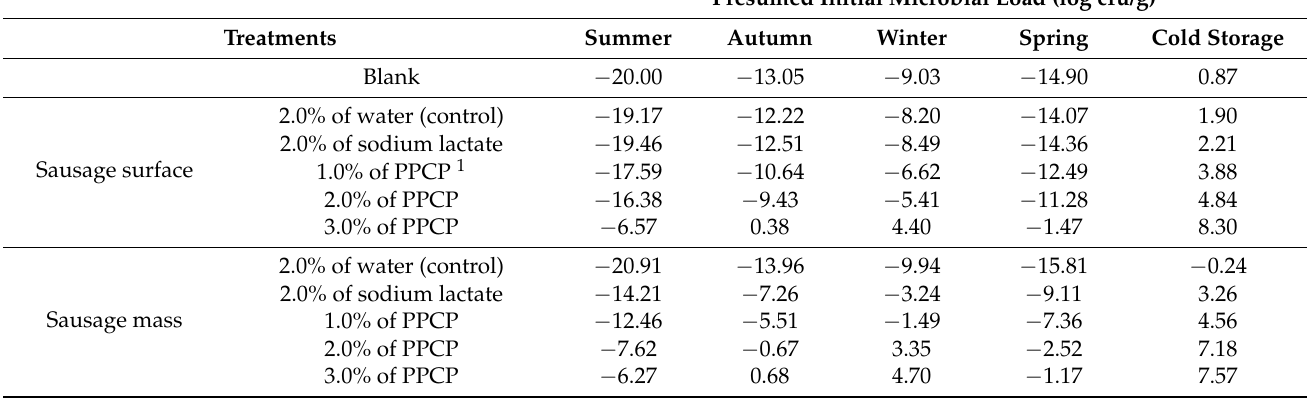
Table 6. Estimated initial microbial load of vacuum-packaged cooked sausages to achieve the predictive model’s borderline of 90